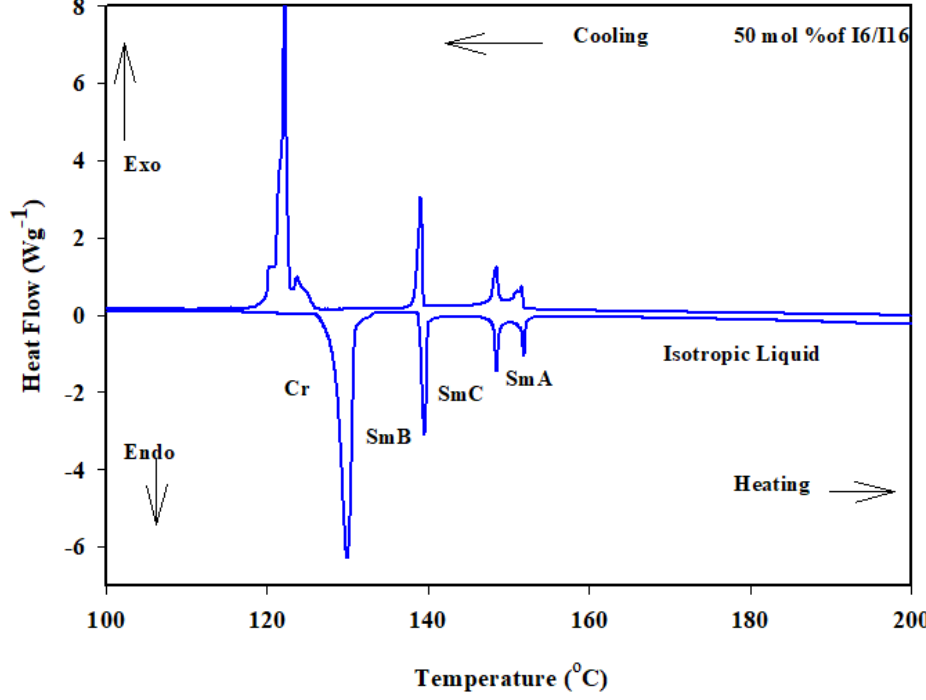
Figure 4. DSC thermogram for 50 mol% I6 / I16 binary system during heating and cooling states at rate 10 °Cmin − 1 .